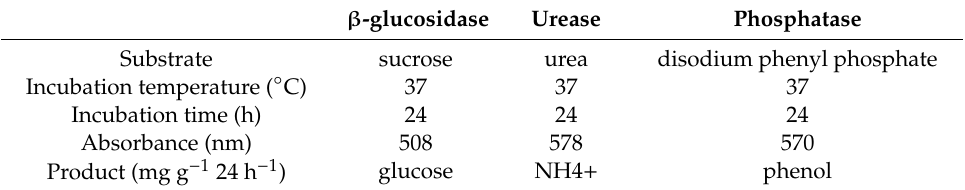
Table 3. Substrates, incubated conditions, and products of soil enzyme activities assays. β